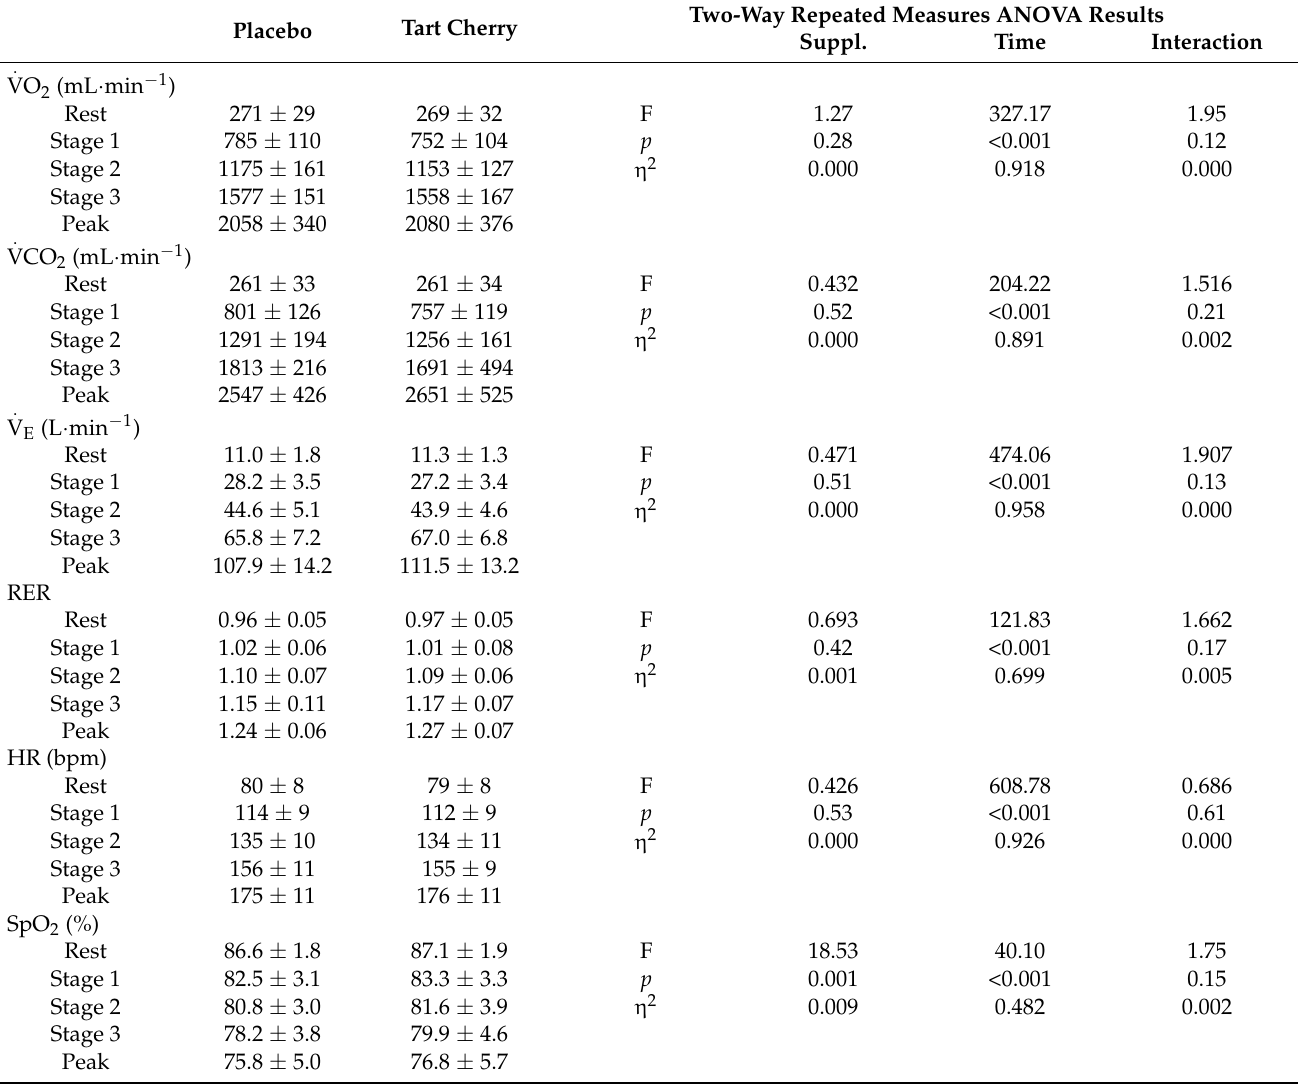
Table 1. Cardiorespiratory responses at rest, during submaximal exercise (Stages 1, 2, and 3), and at exercise exhaustion (peak) after 5 days of placebo and tart cherry